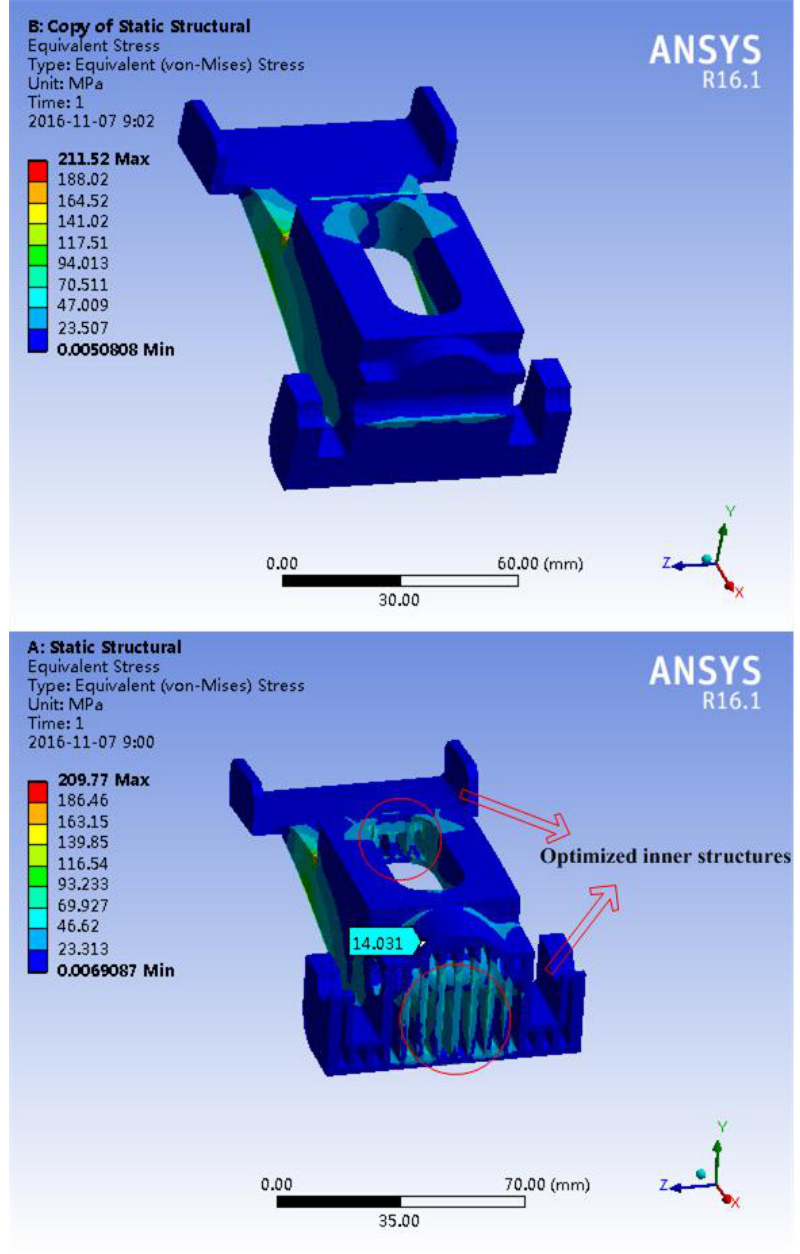
Figure 20. Stress distribution of original ( up ) and redesigned ( down ) stopper.